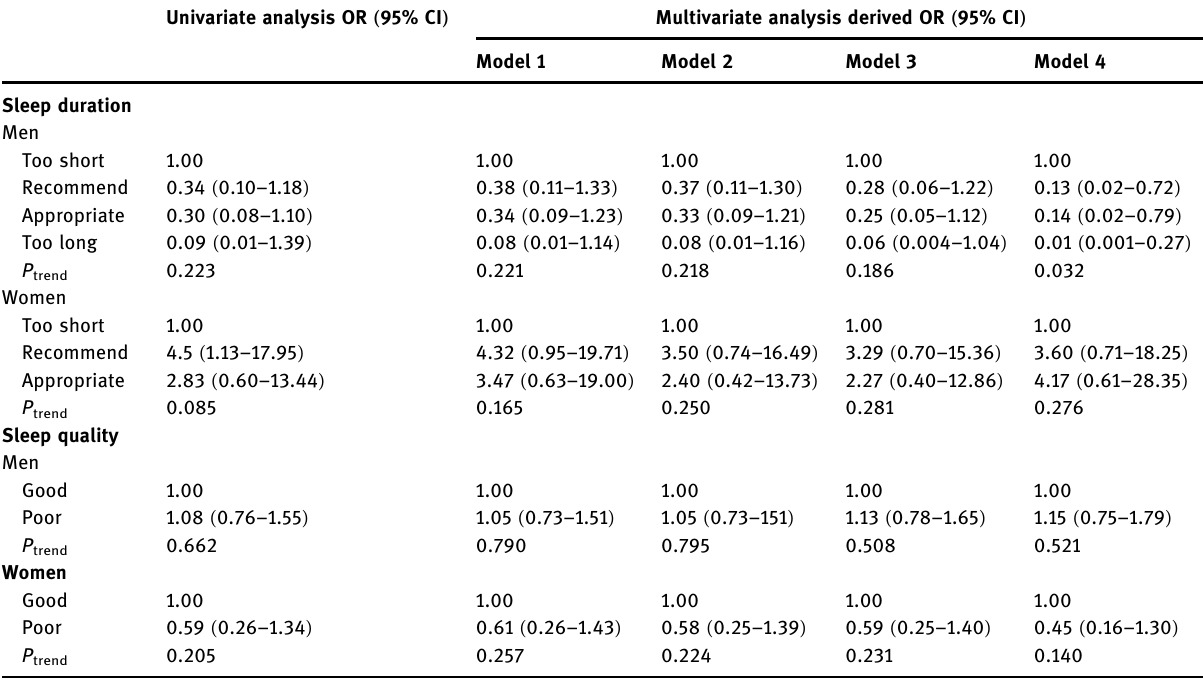
Table 4: Relationships between sleep duration, sleep quality, and NAFLD Univariate analysis OR ( 95% CI ) Multivariate analysis derived OR ( 95% CI